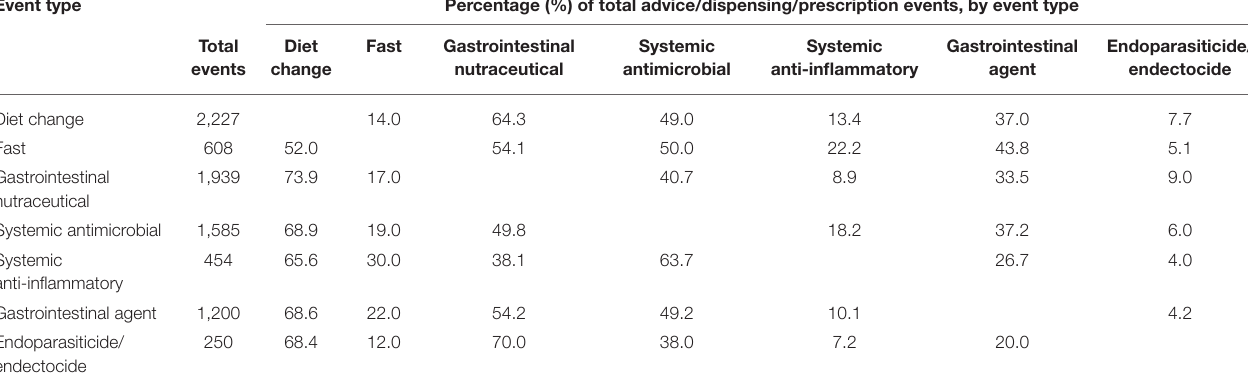
TABLE 4 | Descriptive summary of cases where multiple sets of advice, nutraceutical dispensing, or pharmaceutical prescriptions were provided, expressed as a percentage of total cases where each “event type” was provided. Event type